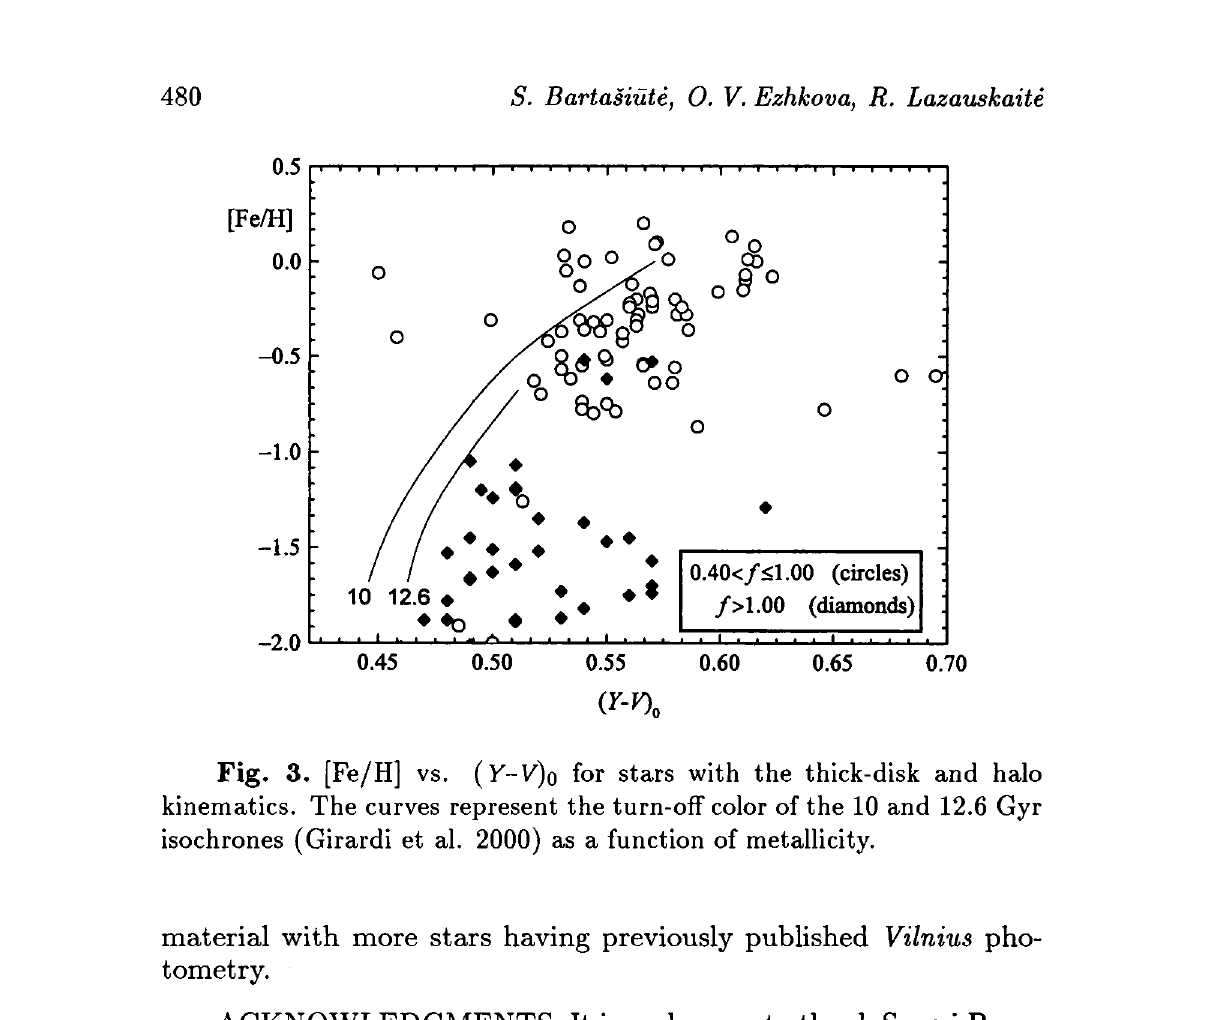
Fig. 3. [Fe/H] vs. for stars with the thick-disk and halo kinematics. The curves represent the turn-off color of the 10 and 12.6 Gyr isochrones (Girardi et al. 2000) as a function of metallicity.